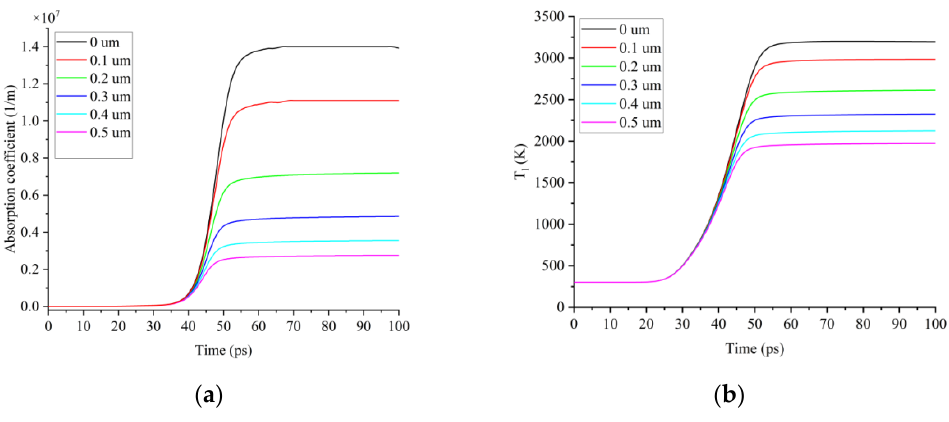
Figure 6. ( a ) z-axis absorption coefficient; ( b ) z-axis lattice temperature.